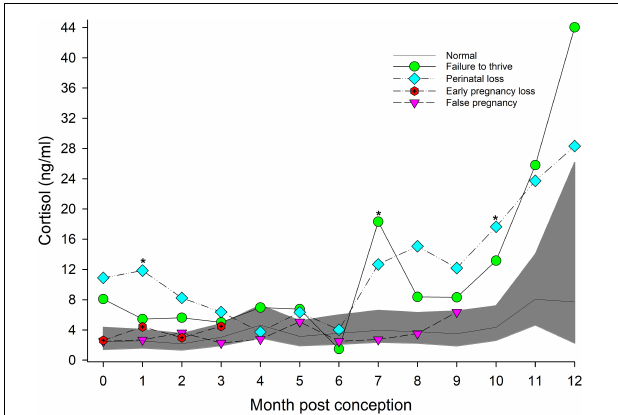
FIGURE 3 | The marginal predicted 95% CI for cortisol during each month post-conception (MPC) of normal pregnancies as represented by the dark gray shaded portion of the graph and the mean by a solid black line. Line graphs with data points represent each abnormal pregnancy (marginal mean). MPC of abnormal pregnancies which have mean concentrations that are significantly different from normal are highlighted with an asterisk (*). Data were log transformed for analysis and then back-transformed for data